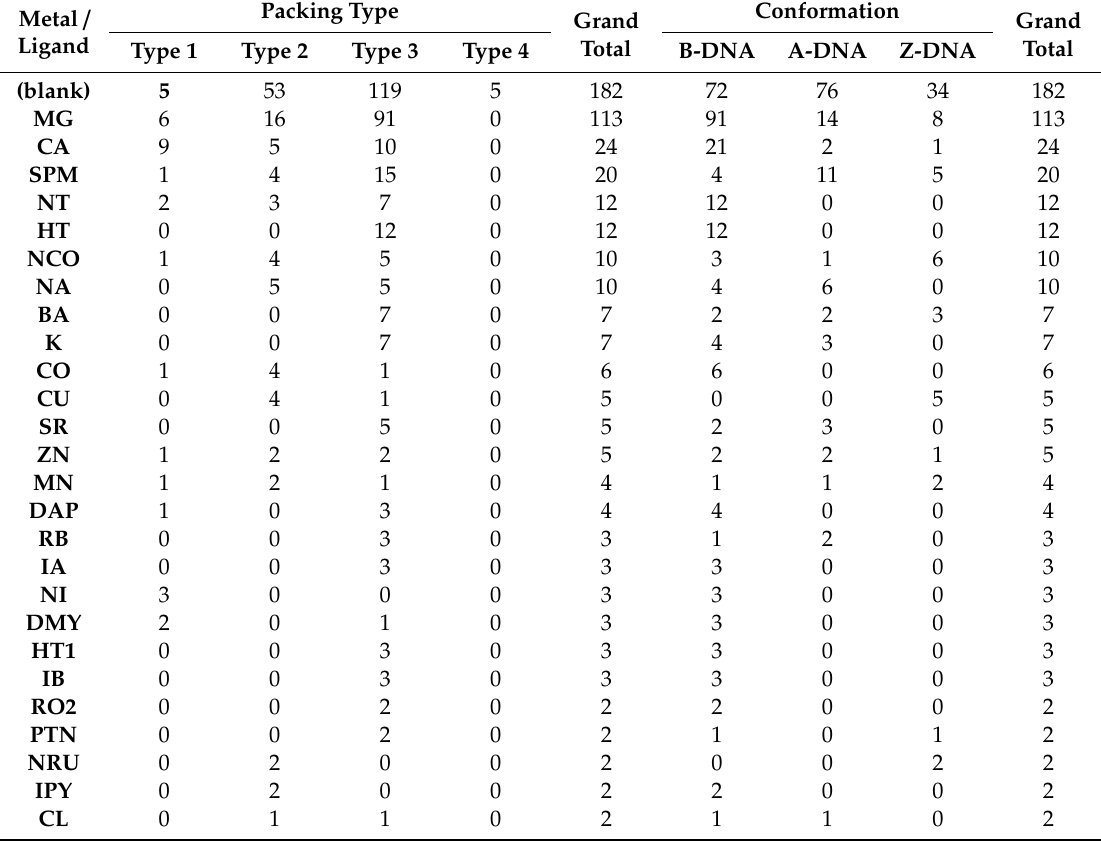
Table 6. Number of DNA structures containing di ff erent metal / ligands, their packing types, and conformations. Full list is provided in Table